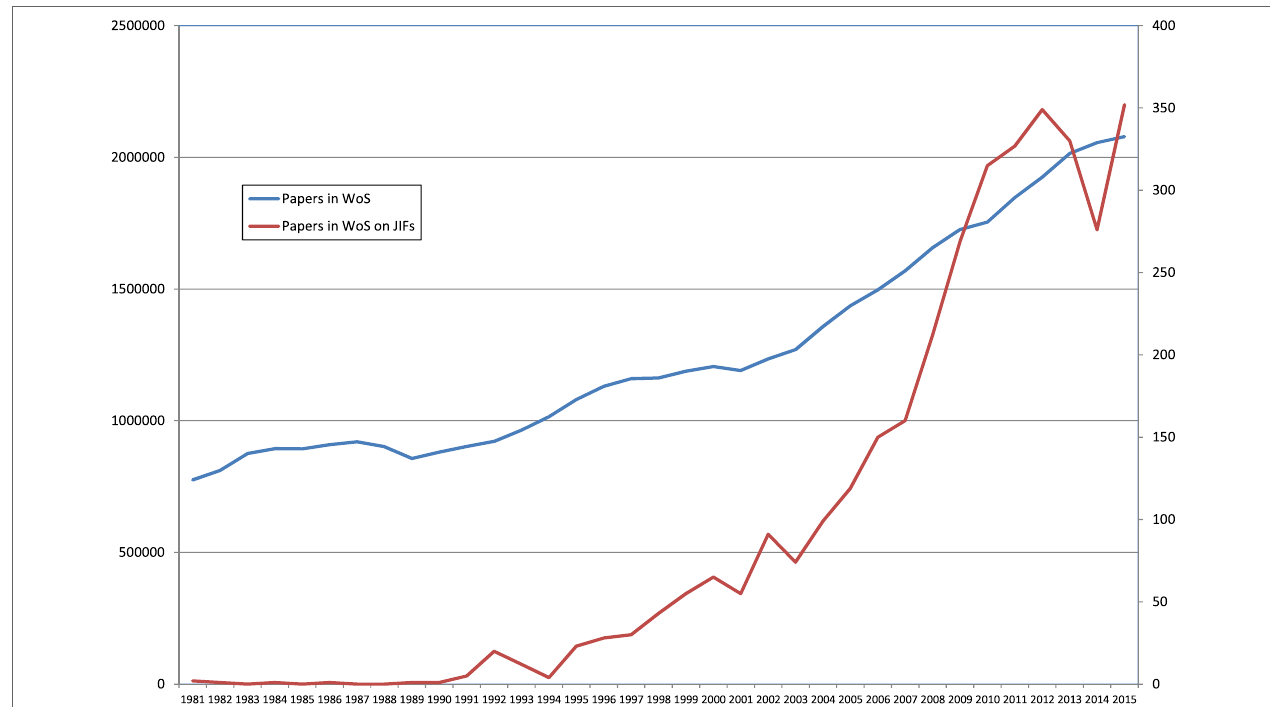
FigUre 1 | Trend analysis of output in Wos on Journal impact Factors (JiFs), 1981–2015